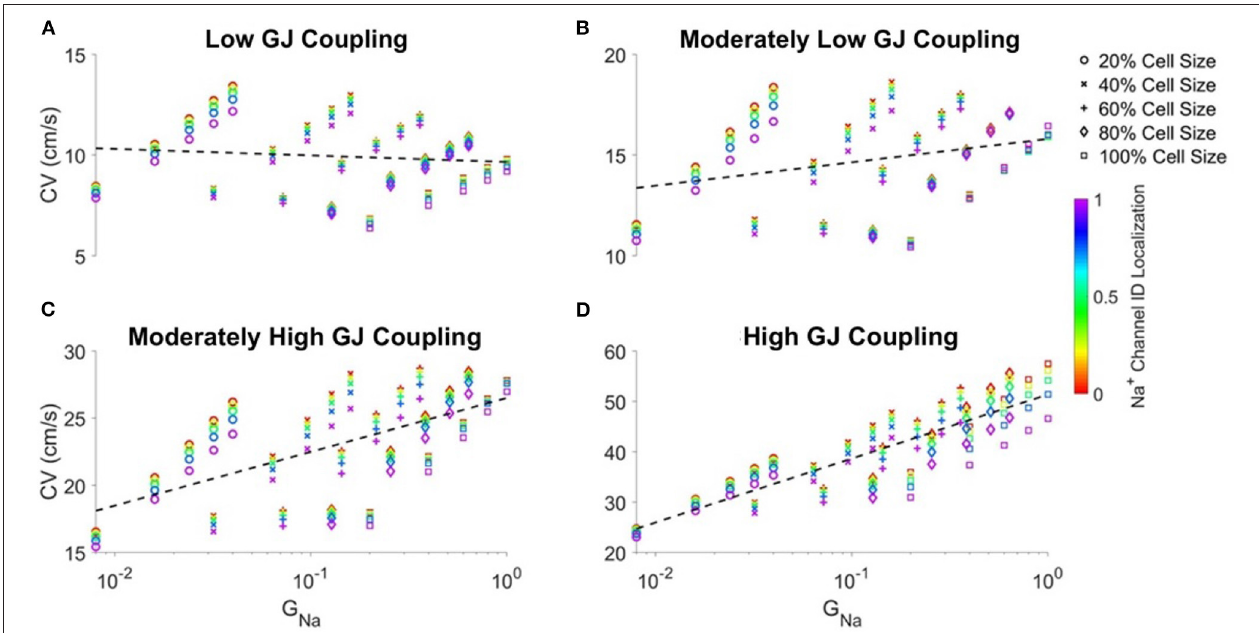
FIGURE 4 | Correlation between conduction velocity (CV) and total cell Na + conductance ( G Na ) increases as gap junctional coupling increases. Conduction velocity (CV) is shown as a function of G Na for different cell sizes and Na + channel ID localization for (A) low, (B) moderately low, (C) moderately high, and (D) high GJ coupling. Pearson correlation coefficients r for low ( r = − 0.103), moderately low ( r = 0.283), moderately high ( r = 0.607), high ( r = 0.865) GJ coupling. Parameters: Cleft width w = 20 nm .